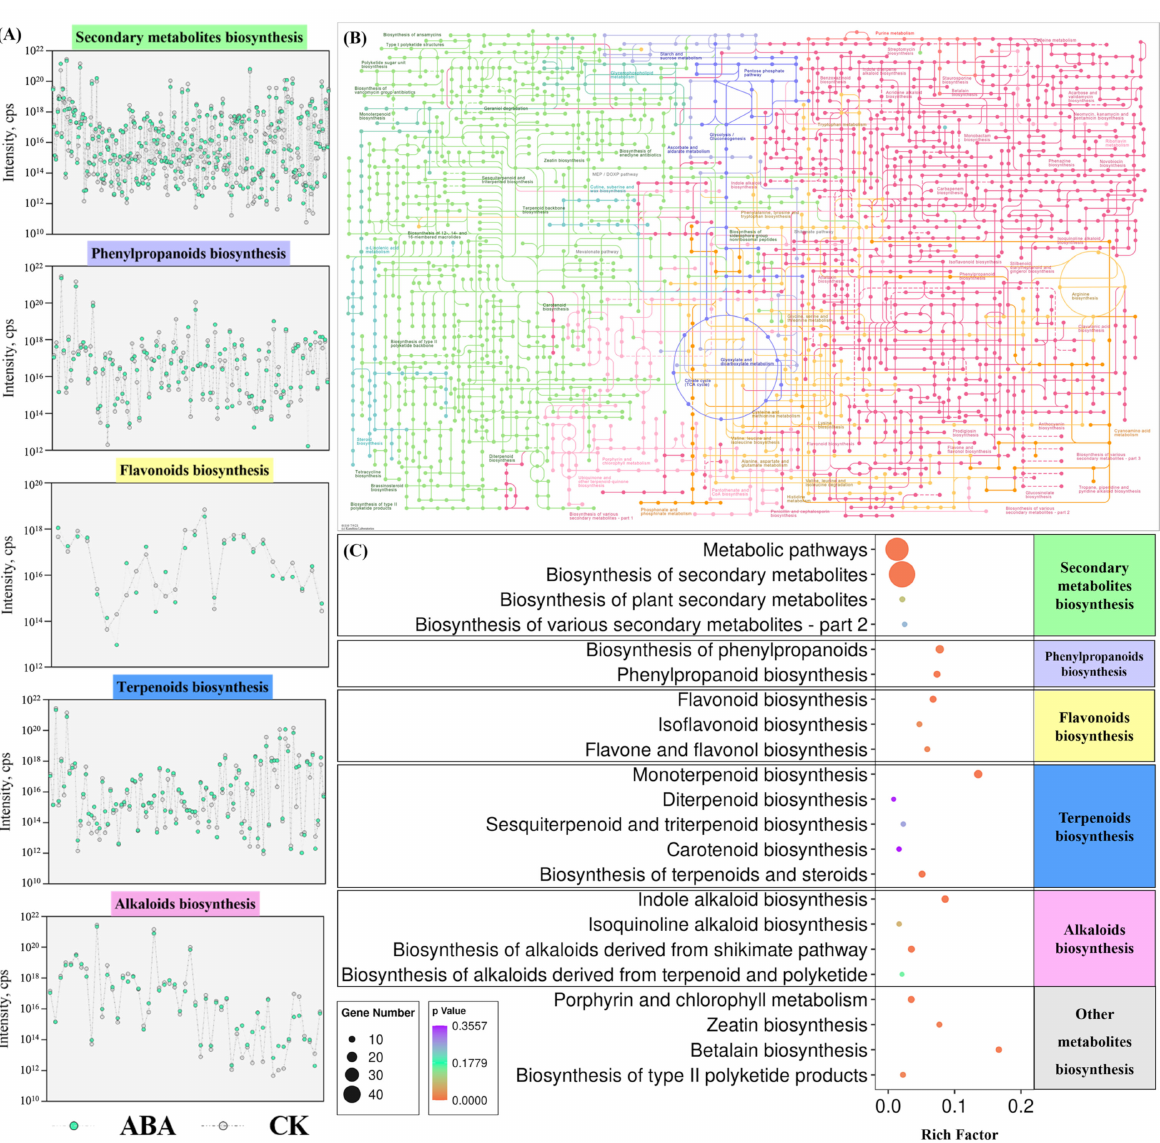
Figure 7. Identification and KEGG annotation of the DAMs between ABA and CK. ( A ) The abun- dances of the DAMs belonging to different metabolic categories. ( B ) Overview of the metabolic pathways of DAMs between ABA and CK. ( C ) Statistical analysis of DAMs enriched in the secondary metabolite biosynthesis pathways by KEGG